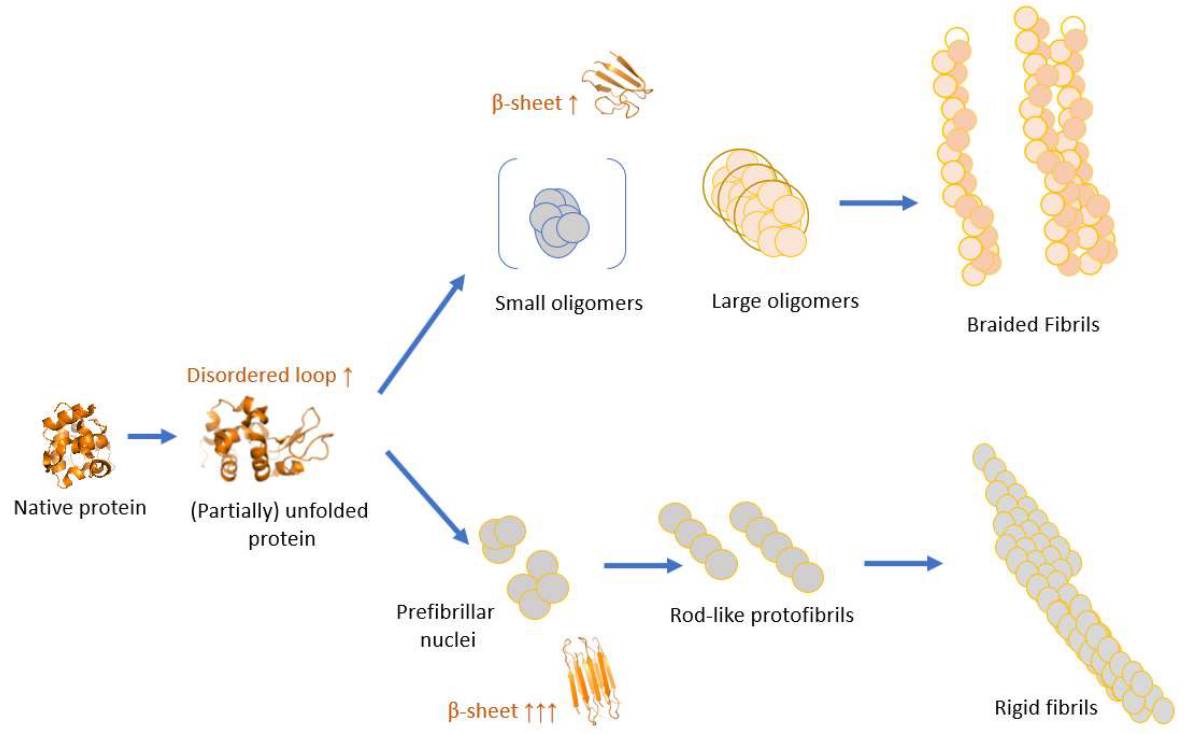
Figure 1. The fibrilization process for folded proteins starts with a partial unfolding step. There are two main pathways that protein fibrilization can follow; the top pathway shows the oligomeric pathway where a small structural reorganization occurs (typically enrichment with β-sheets), and protein molecules agglomerate into oligomers. Oligomers can associate into fibrils with a braided fibril morphology [15–17]. The bottom pathway shows the oligomeric-free assembly (also called nucleated polymerization [18]), where a more profound structural rearrangement occurs resulting in prefibrillar nuclei. In the elongation or growth phase, these nuclei are extended into an organized conformation with the cross β-structure (protofibril) whereas in the steady phase the protofibrils associate into mature fibrils. The scheme is based on [19–21].